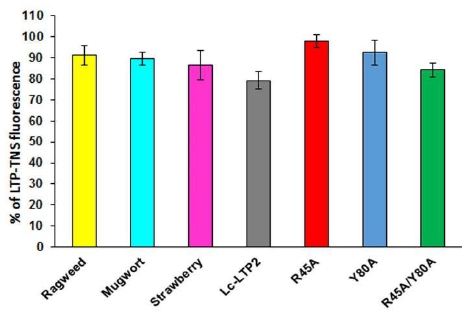
Figure 2. Effect of PI(4,5)P2 on the fluorescence level of the LTP-TNS complex. The results are expressed as the mean values (±SD) of the fluorescence percentage using the LTP – TNS complex without the lipid as a control.